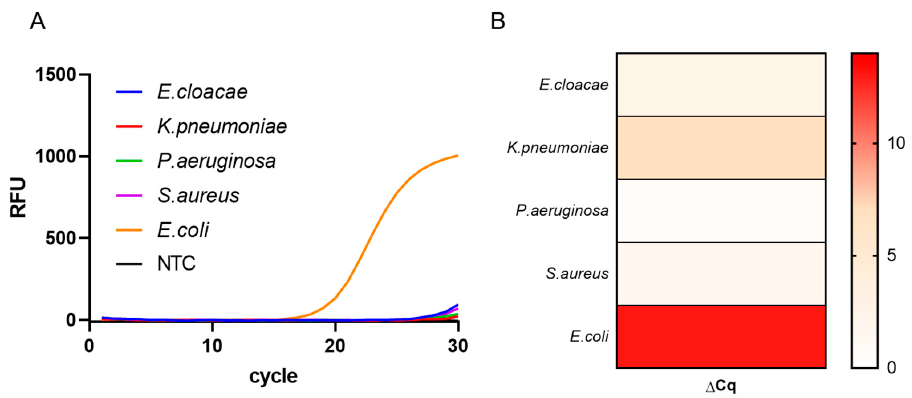
Figure 4. Detection specificity of Escherichia coli gDNA. ( A ) Real-time polymerase chain reaction amplification curves of gDNA (2 ng/ µ L) extracted from different bacteria. ( B ) Heatmap of delta Cq values of gDNA (2 ng/ µ L) extracted from different bacteria. The delta Cq was calculated by subtracting the Cq value of the control from the Cq value of each sample. Data are expressed as mean ± standard deviation; n = 3 technical replicates. gDNA, genomic DNA; Cq, cycle quantification; RFU, relative fluorescence unit; NTC, non-template